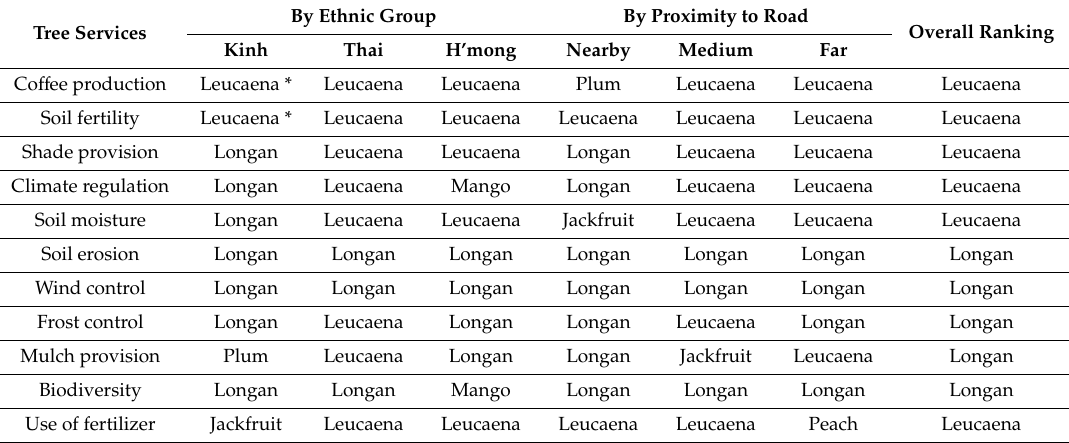
Table 3. Best tree species ranked by farmers with respect to the tree services provision to co ff ee in agroforestry practices (grouped by ethnicity and proximity to main